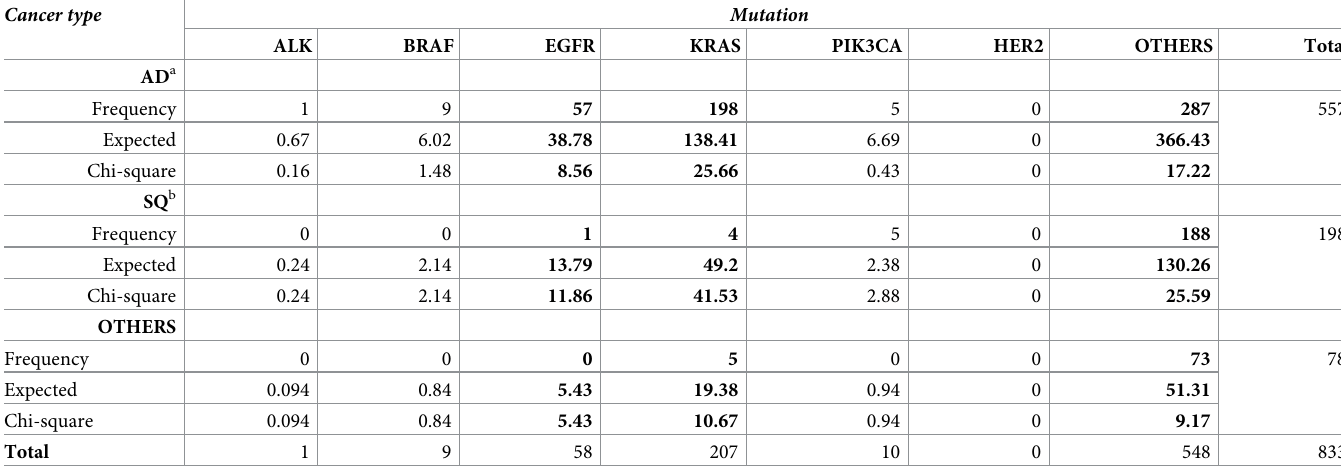
Table 2. Statistics table of cancer type by mutation in the 833 samples. Cancer type